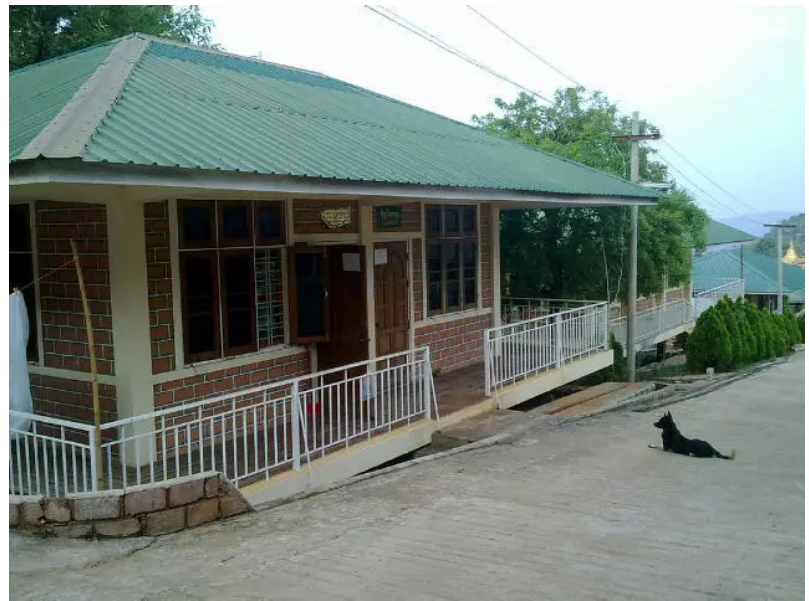
Figure 2. Accommodation of Shweooming meditation center, Yangon, Myanmar (from Yaozhen’s blog (Yaozhen 2016)).